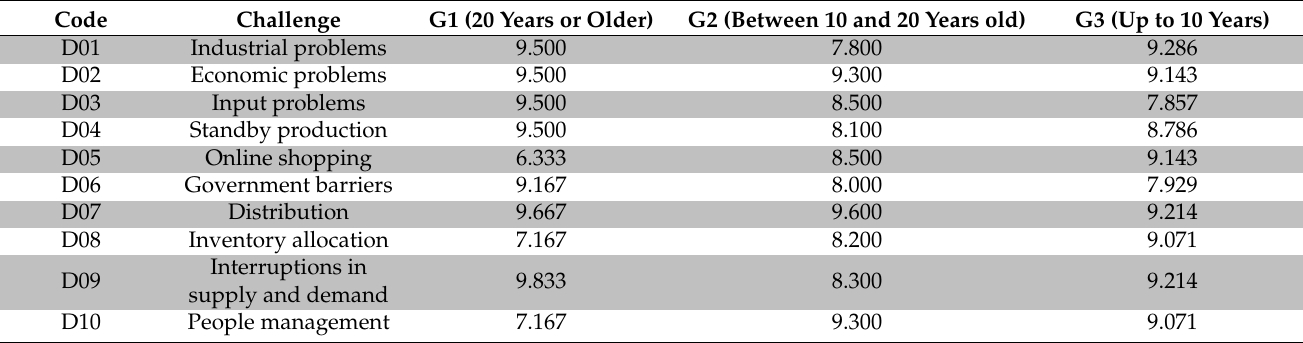
Table 2. Averages attributed to